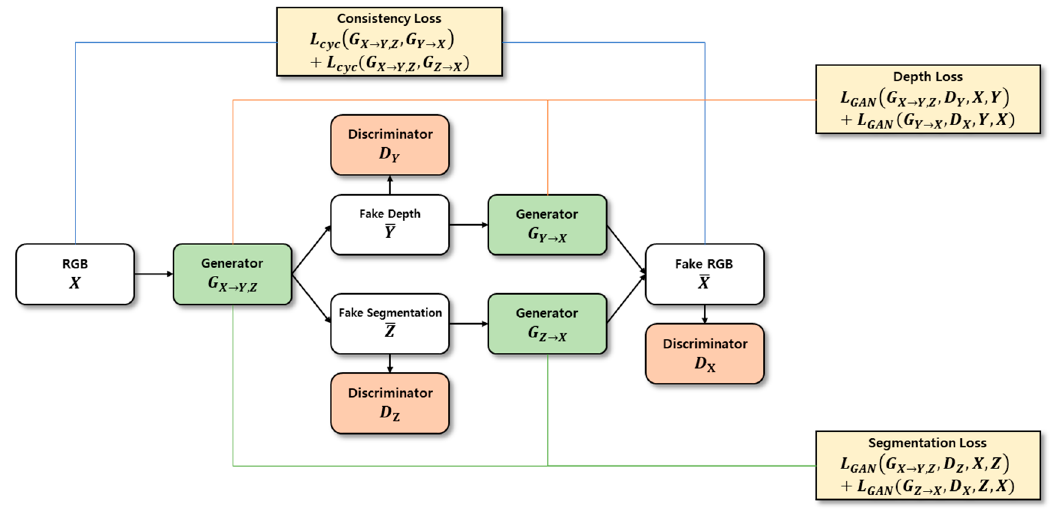
Figure 2. Outline of the proposed depth estimation method.